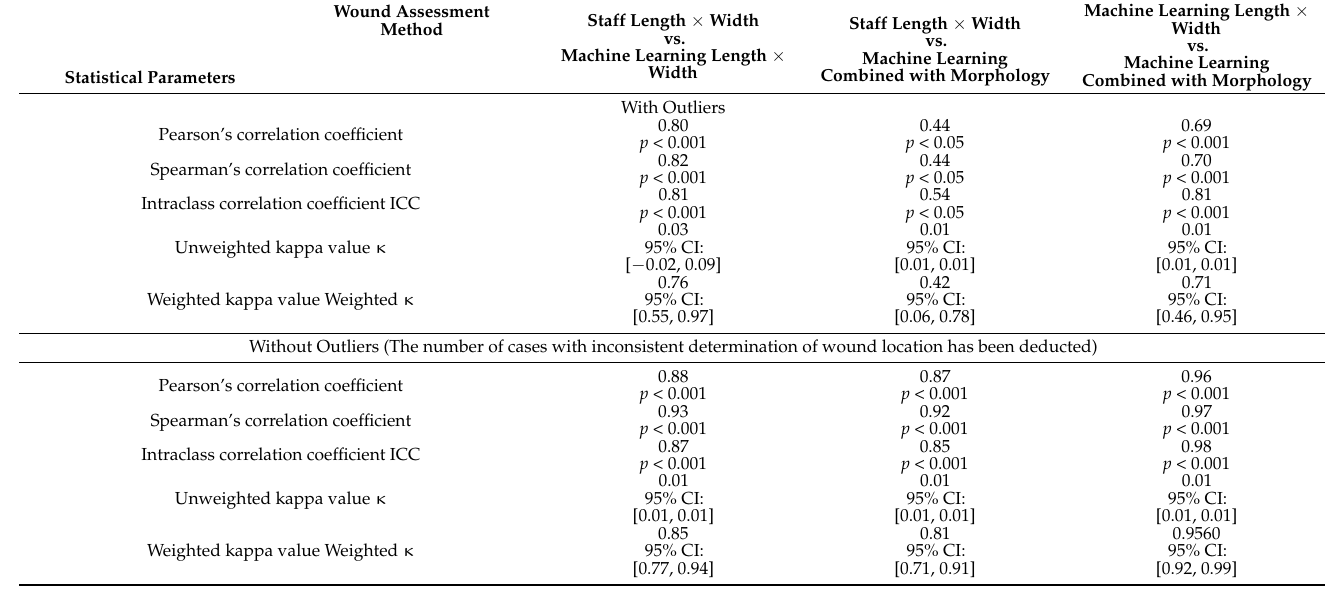
Table 4. Comparison of related statistical parameters of various wound area methods.